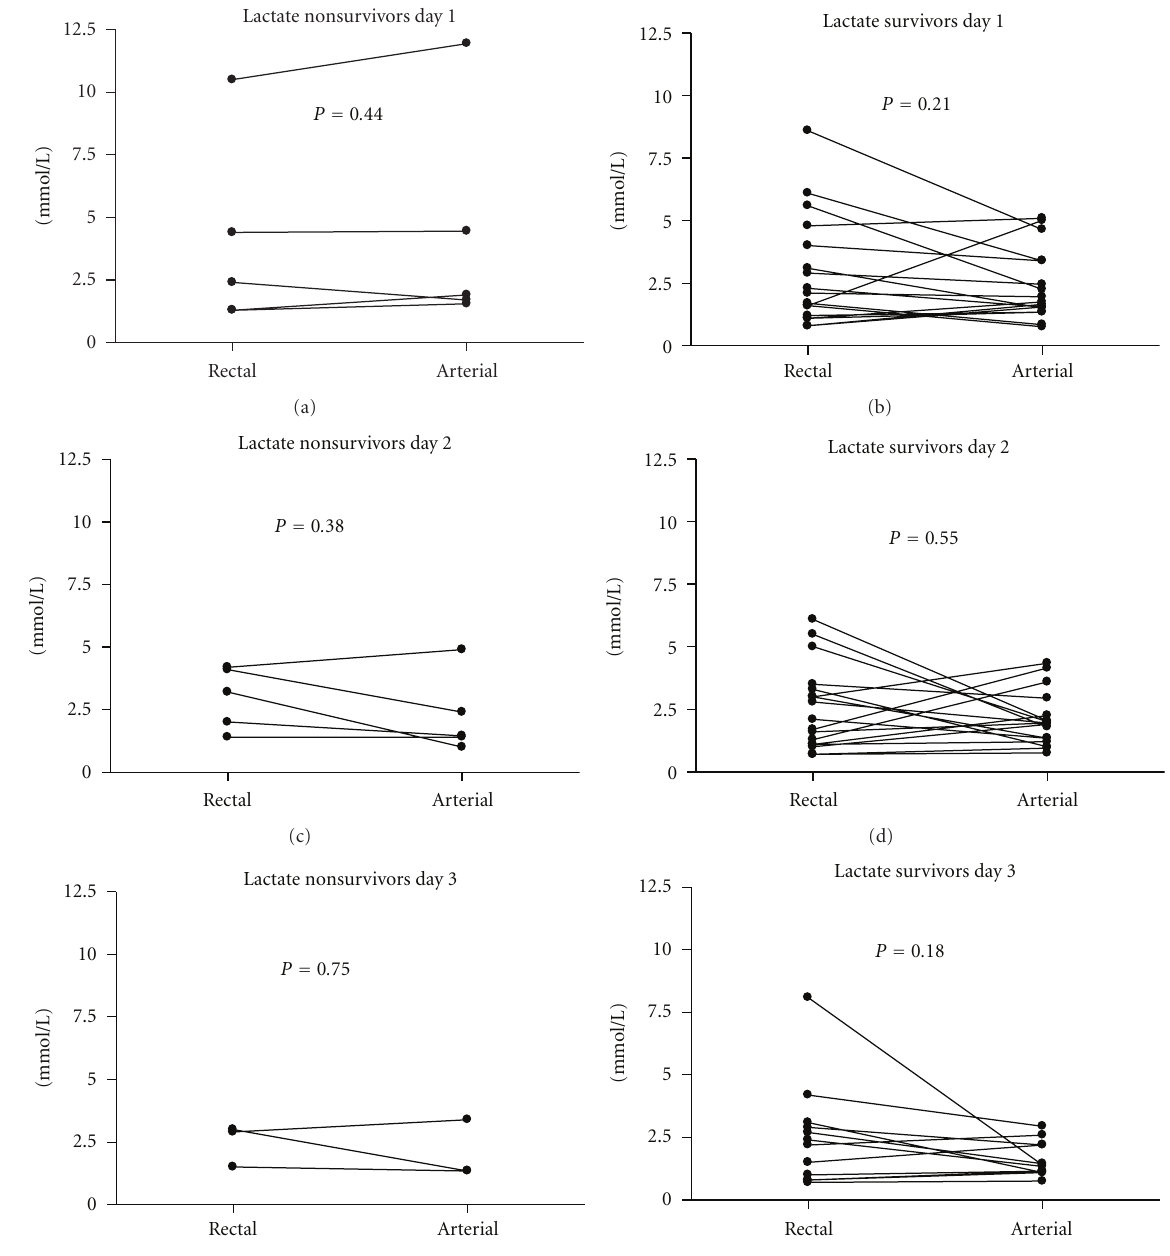
Figure 2: Rectal and arterial concentrations of lactate in nonsurvivors and survivors of septic shock. There were no di ff erences using Wilcoxon’s signed rank